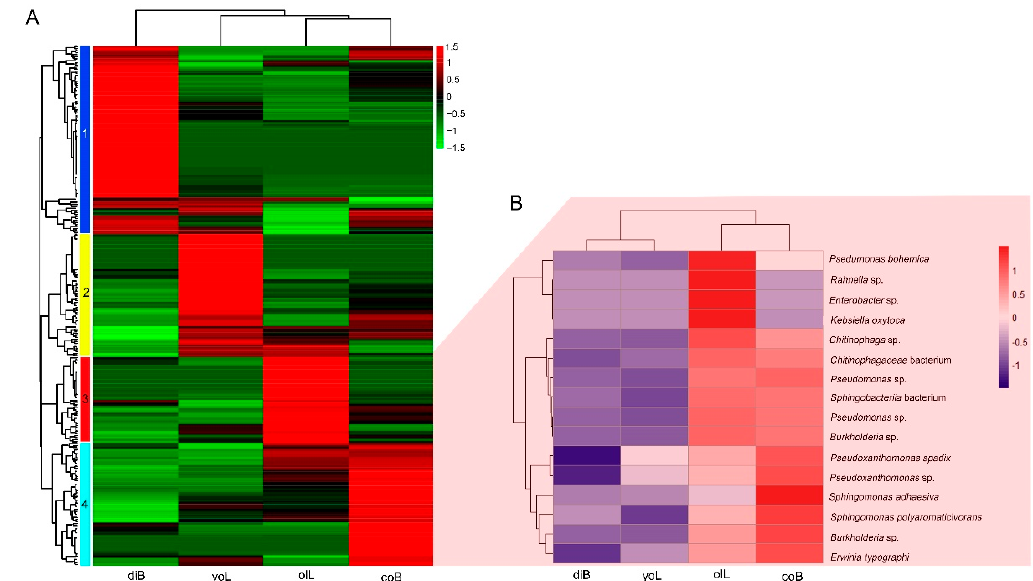
Figure 3. Species level composition. ( A ) Hierarchical clustering analysis of gut bacteria of D. valens at different life stages. Bacterial dendrogram is divided into four clusters that are marked by different color-coded boxes on the left (species in each cluster are listed in Table S1). ( B ) Heatmap showing 16 gut bacteria species with significant differences in abundance between groups (Kruskal–Wallis test, df = 3, FDR-corrected p < 0.05).